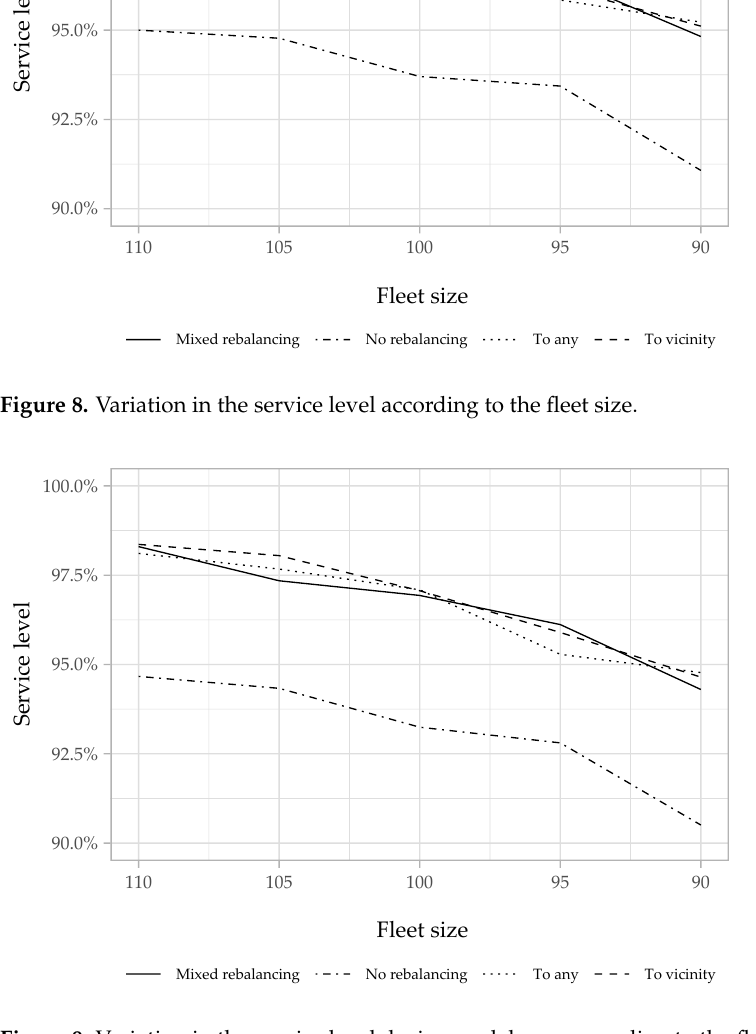
Figure 9. Variation in the service level during peak hours according to the fleet